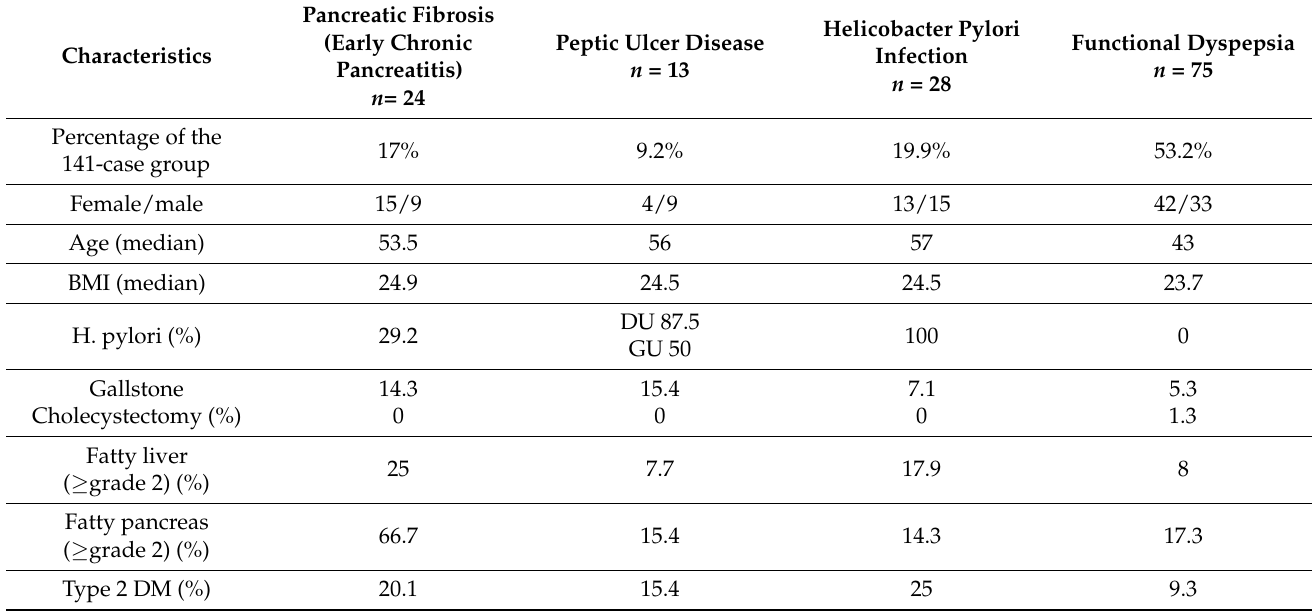
Table 1. The demography of the subgroups of the dyspeptic population.